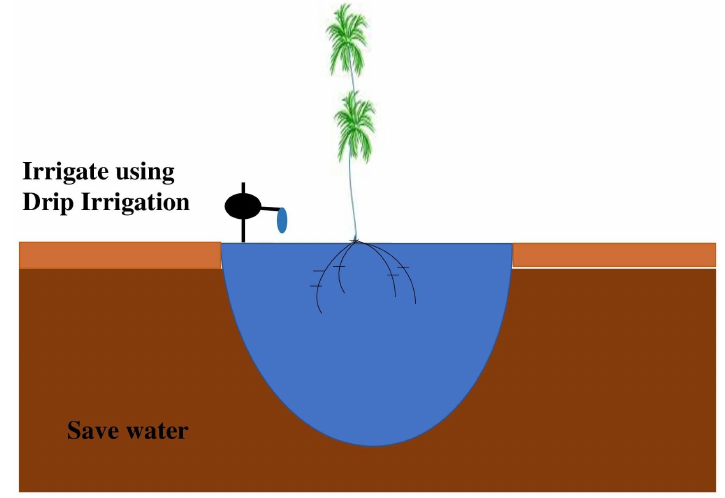
Figure 2. The proliferation of water stress in the plant. The percentage of the area wetted and the volume of soil wetted depend on the properties of the soil, its initial moisture content, the volume of water applied, and the flow rate of the emitter. In free-flowing or clay soils, the lateral movement of water below the soil surface is more pronounced than in sandy soils. The vertical bulb of wetted soil in sandy soil resembles a core. In free soil, the dimensions of the wet bulb are similar in depth and diameter. In heavy soils, however, the horizontal zone of moisture extension is larger than its